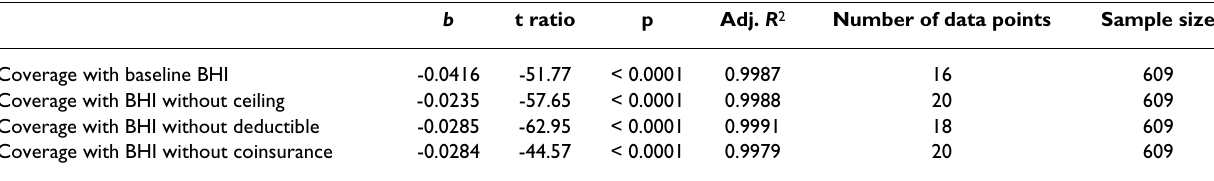
Table 4: Demand curve